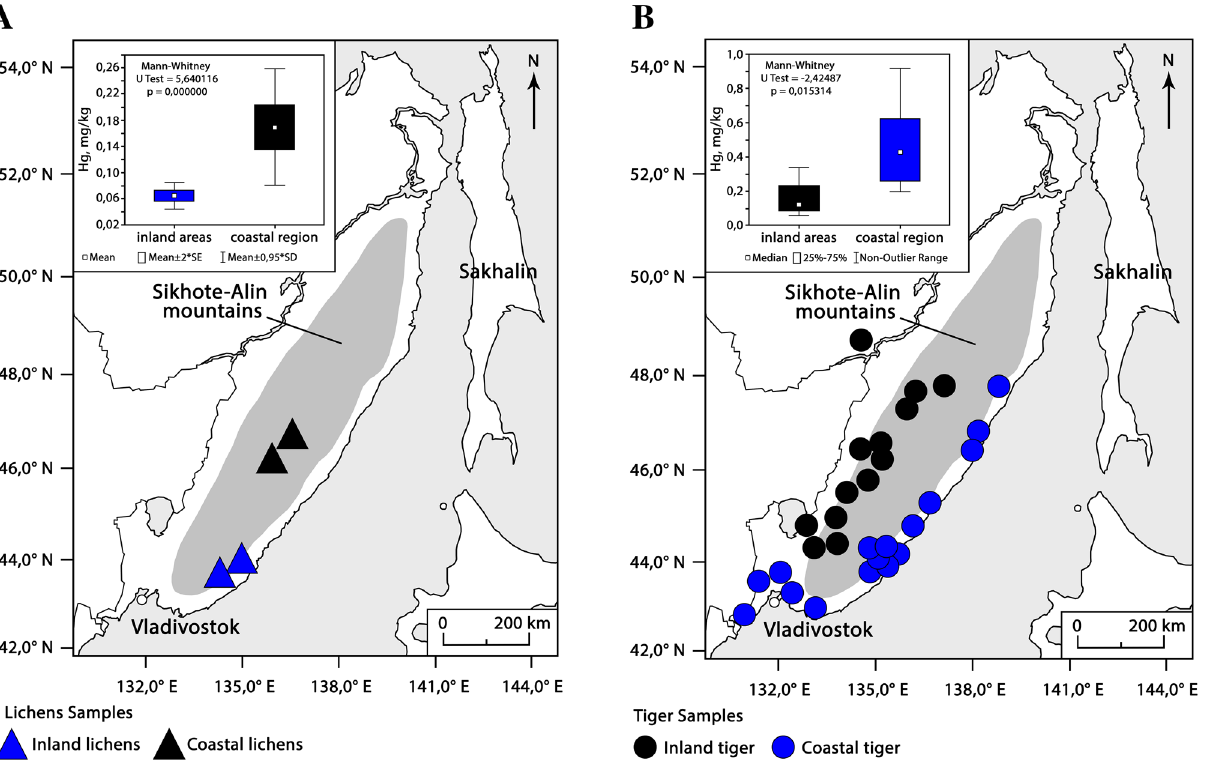
Figure 1. Map of sampling sites and mean values of ( A ) THg concentrations in lichen ( Usnea sp.) (site names correspond to data in Table 1), ( B ) THg in tiger fur. The blue triangles and circles represent the samples from coastal sub-region and the black—from inland sub-region. Lichen sampling was done in 2019 and tiger fur sampling was done in 2004–2014. The map was generated in Adobe Photoshop CS6, based on a map from the public domain on the site https:// yandex. ru/ legal/ maps_ terms ofuse/? lang= en.